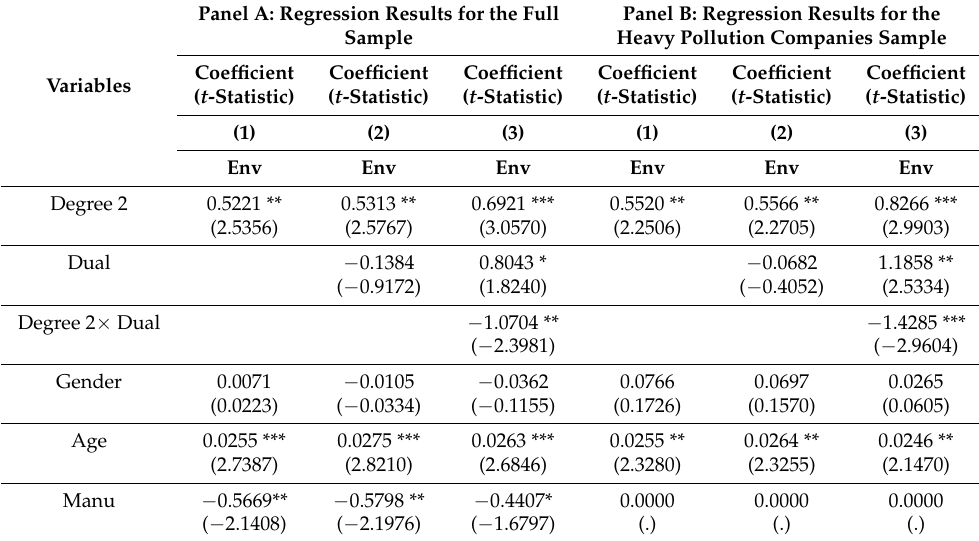
Table 7. Regression results: alternative measure of the CEO degree. Panel A: Regression Results for the Full Panel B: Regression Results for the Sample Heavy Pollution Companies Variables